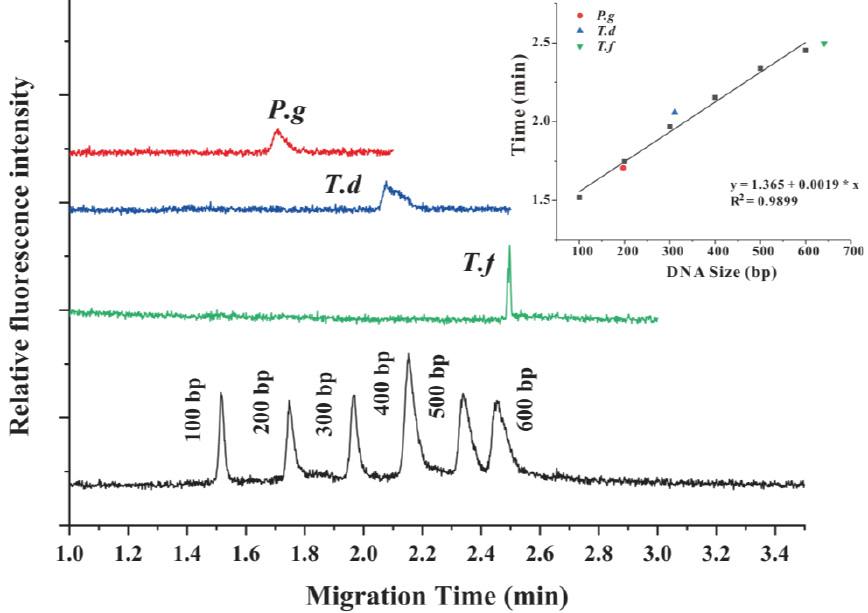
Figure 5. The electropherogram of periodontal pathogens after they were amplified in the CF-PCR- MCE system.